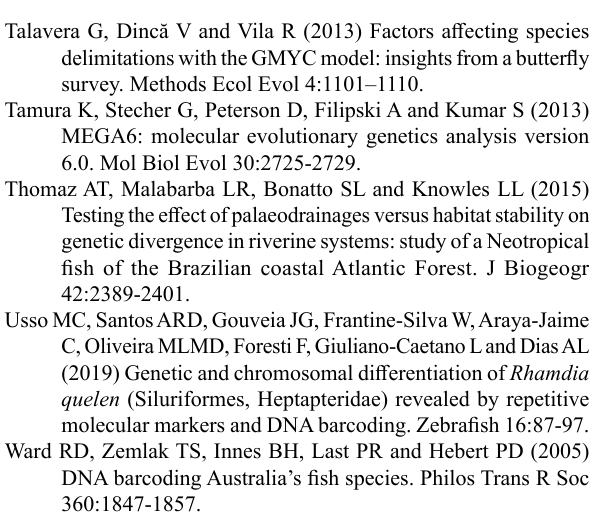
Figure S1 – Bayesian inference topology of Rhamdia based on COI sequences. Figure S2 – Time-calibrated topology of Rhamdia and